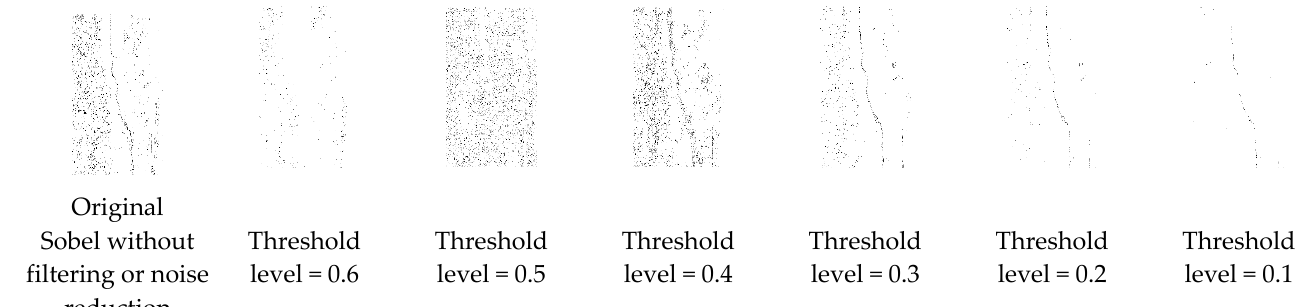
Figure 7. Obtained images using different threshold levels to identify which is appropriate to determine the visible crack region of sample images.